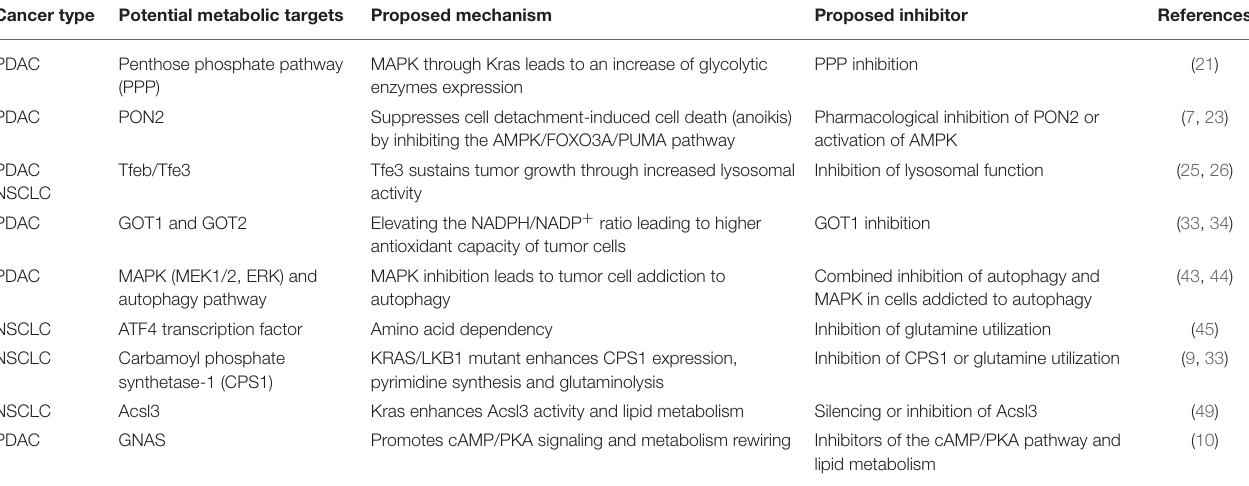
TABLE 1 | Summary of potential metabolic targets in PDAC and